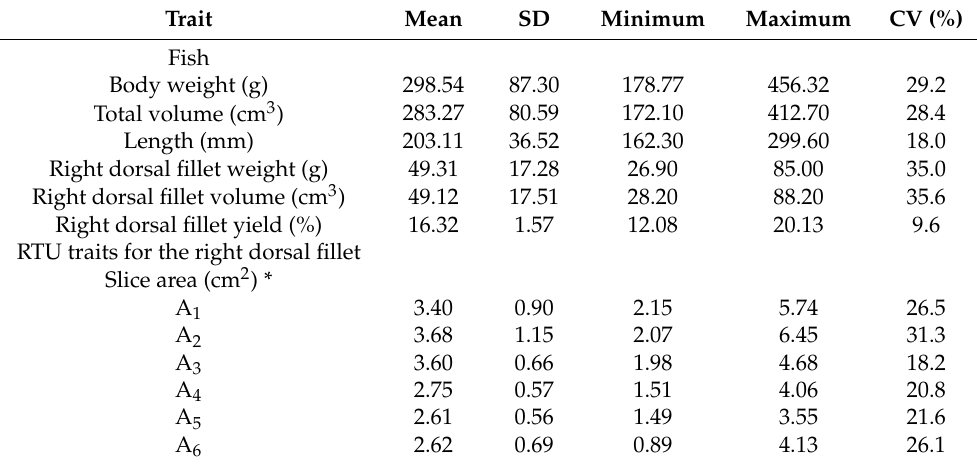
Table 1. Mean, standard deviation (sd), minimum, maximum and coefficient of variation (CV) for fish and real-time ultrasonic (RTU) traits (n = 44).